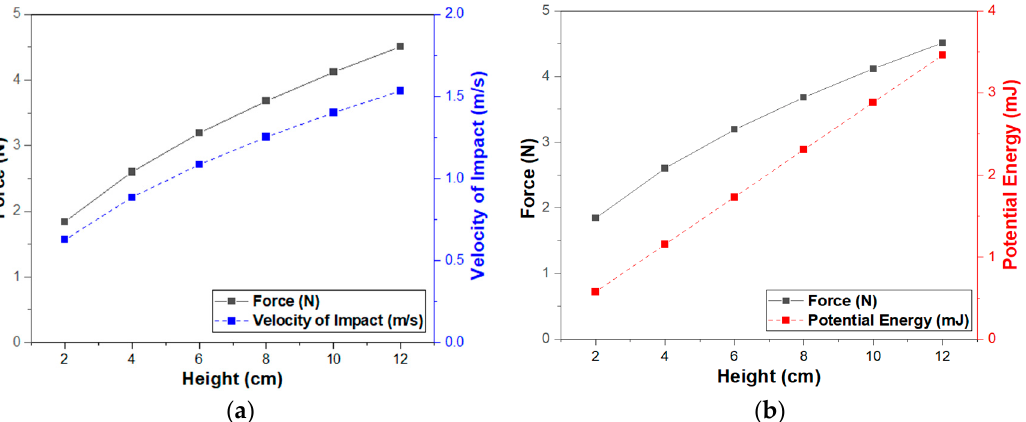
Figure 8. Theoretically calculated impact force ( F impact ), velocity of impact ( v impact ), and potential energy: ( a ) impact force and velocity of impact as a function of drop height; ( b ) impact force and potential energy as a function of drop height.